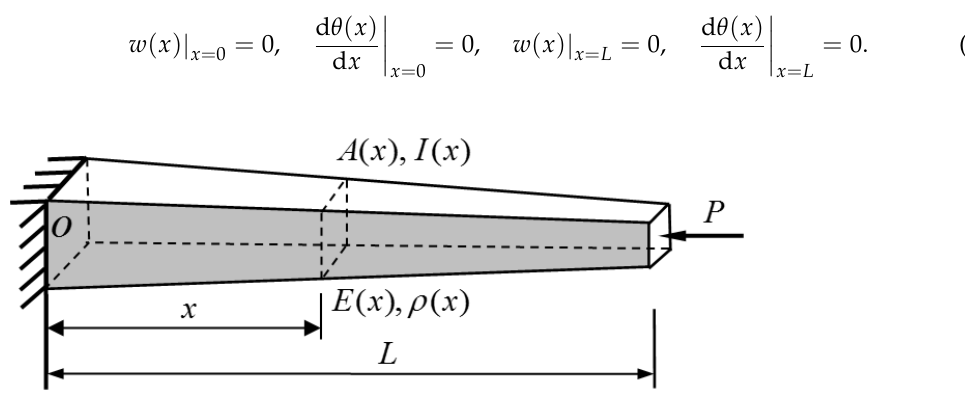
Figure 1. Schematic of an axially functionally graded Timoshenko beam with a varying section. Clamped at both ends of beam